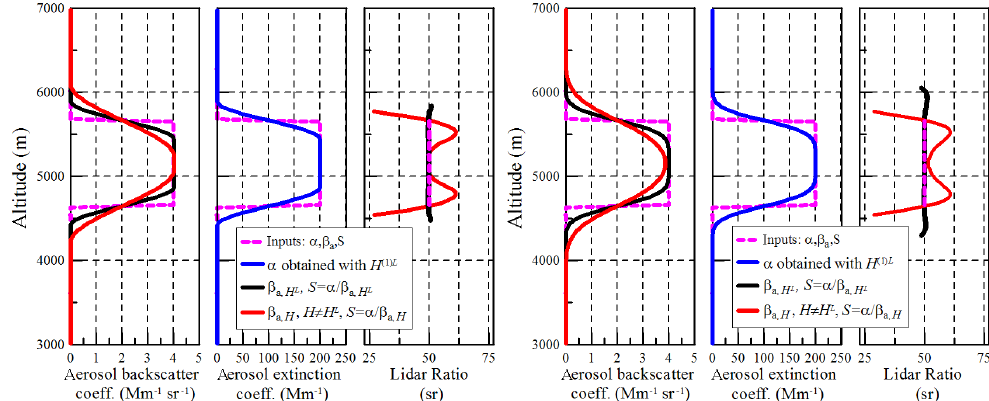
Figure 6. In the left plots, the aerosol extinction profile, α (blue line), has been retrieved by means of an SG2 derivative filter with N = 7 (frequency response is indicated with H ( 1 ) L ) . The aerosol backscatter profile, β a ,H L (black line), is obtained by smoothing the one retrieved at raw resolution (not shown) with the correct low-pass filter: the dSG2 filter with N = 7 (i.e., the smoothing filter H L ) . The other aerosol backscatter profile, β a ,H (red line), is retrieved using a low-pass filter of the same family (dSG2), but with N = 14: then H (cid:54)= H L . The right plots show the same vertical profiles, but using the Gaussian filters. The parameter driving the Gaussian derivative filter is σ . In this case the value used to get the aerosol extinction profile (blue line), α ( σ = 4), it is the same needed in the Gaussian filter to smooth the raw-resolution backscatter profile (black line). A Gaussian filter with a doubled σ value ( σ = 8) is used to obtain the other aerosol backscatter profile, β a ,H (red line). In all the plots the magenta lines indicate the input simulated